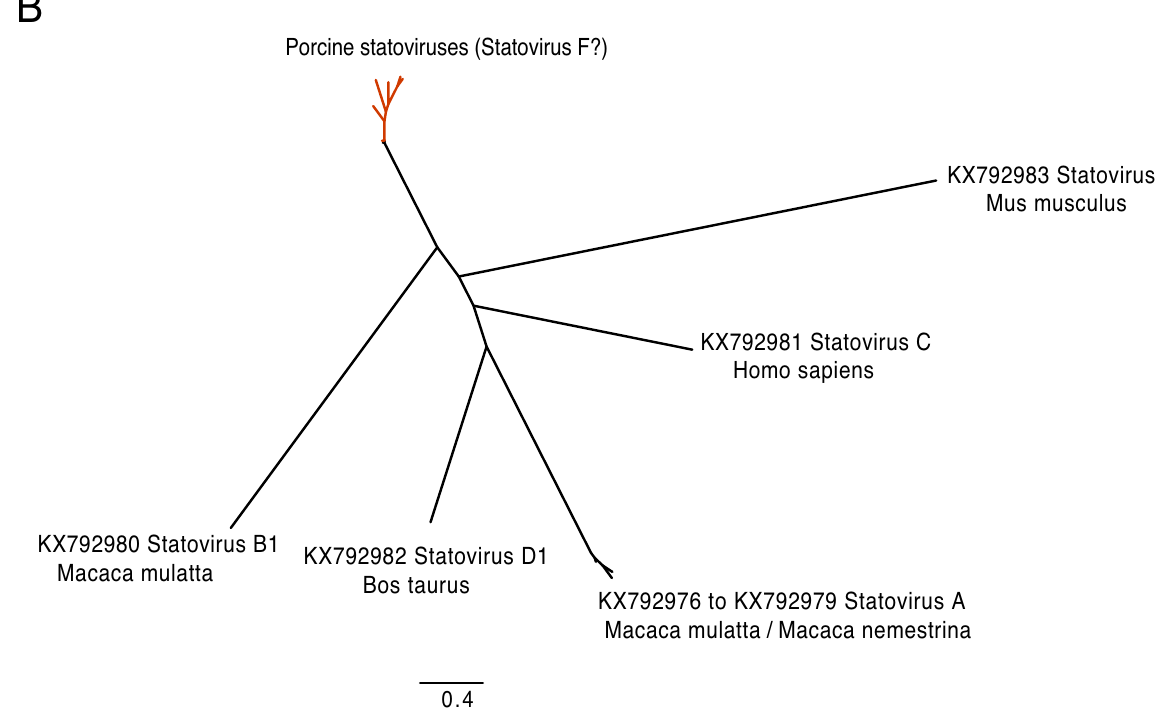
Figure 2. ( A ) Similarity matrix of Posavirus assembled in this study. ( B ) Maximum Likelihood phylogenetic tree of a novel taxon of porcine Statovirus genomes assembled in this